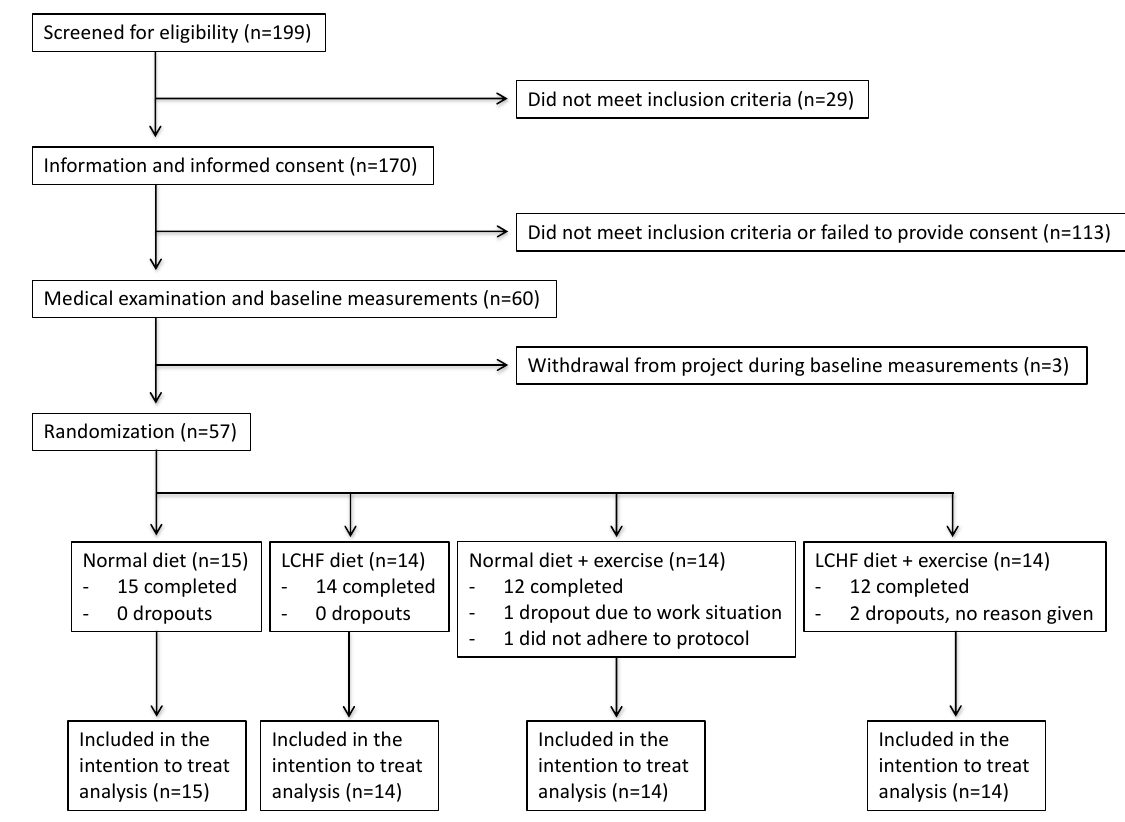
Figure 2. Flow diagram of enrollment and participant flow as recommended by CONSORT.